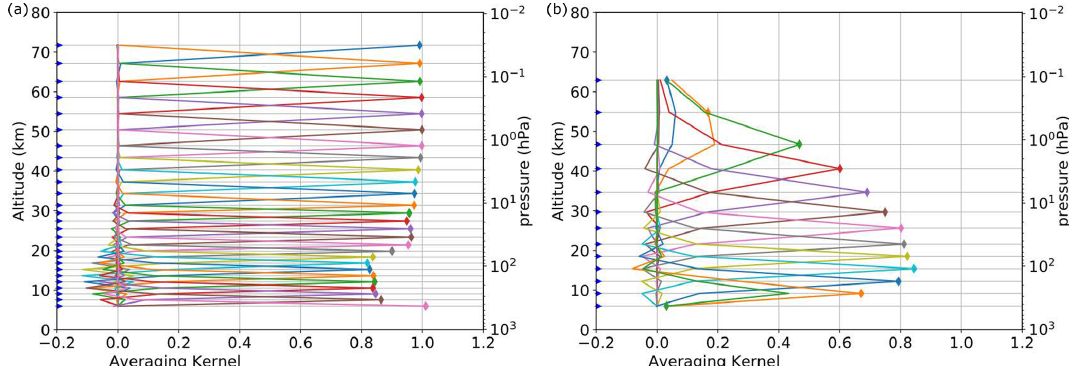
Figure 2. Examples of Averaging Kernels for the OR NOM observation mode: panel (a) for a species retrieved using a posteriori regularisa- tion (Ozone) and panel (b) for a species retrieved with OE (HCN). Table 3. Average number of DOFs for the VMR profiles retrieved from scans not affected by clouds. Target FR NOM OR NOM Tangent points